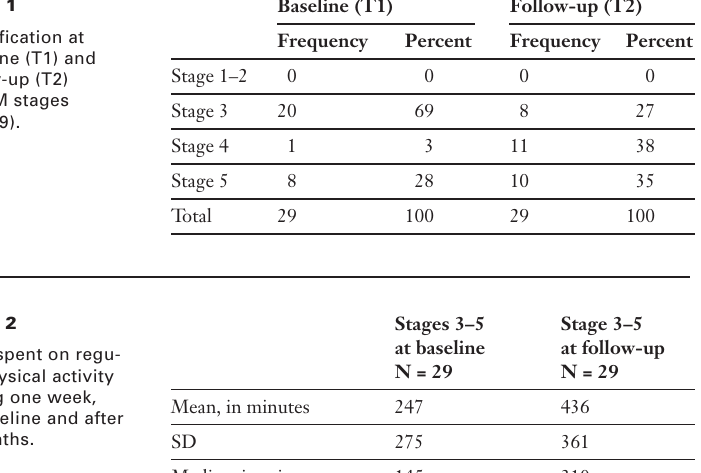
Classification at baseline (T1) and follow-up (T2) in TTM stages (N = 29).